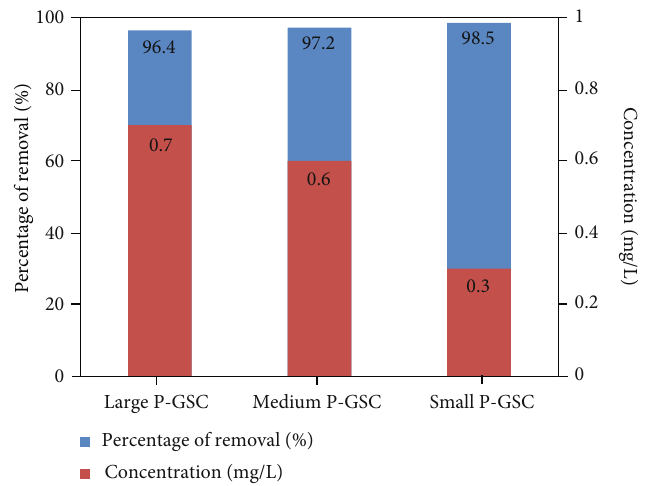
Figure 4: Percentage of MB dye removal by using di ff erent ranges of the particle size of P-GSC.